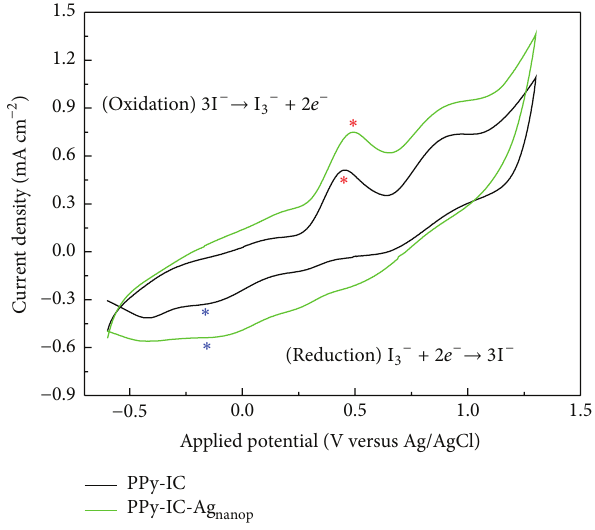
Figure 7: Voltammograms of I − / I 3 − redox reaction at a scan rate of 20 mVs −1 on PPy-IC and PPy-IC-Ag nanop modified electrodes.